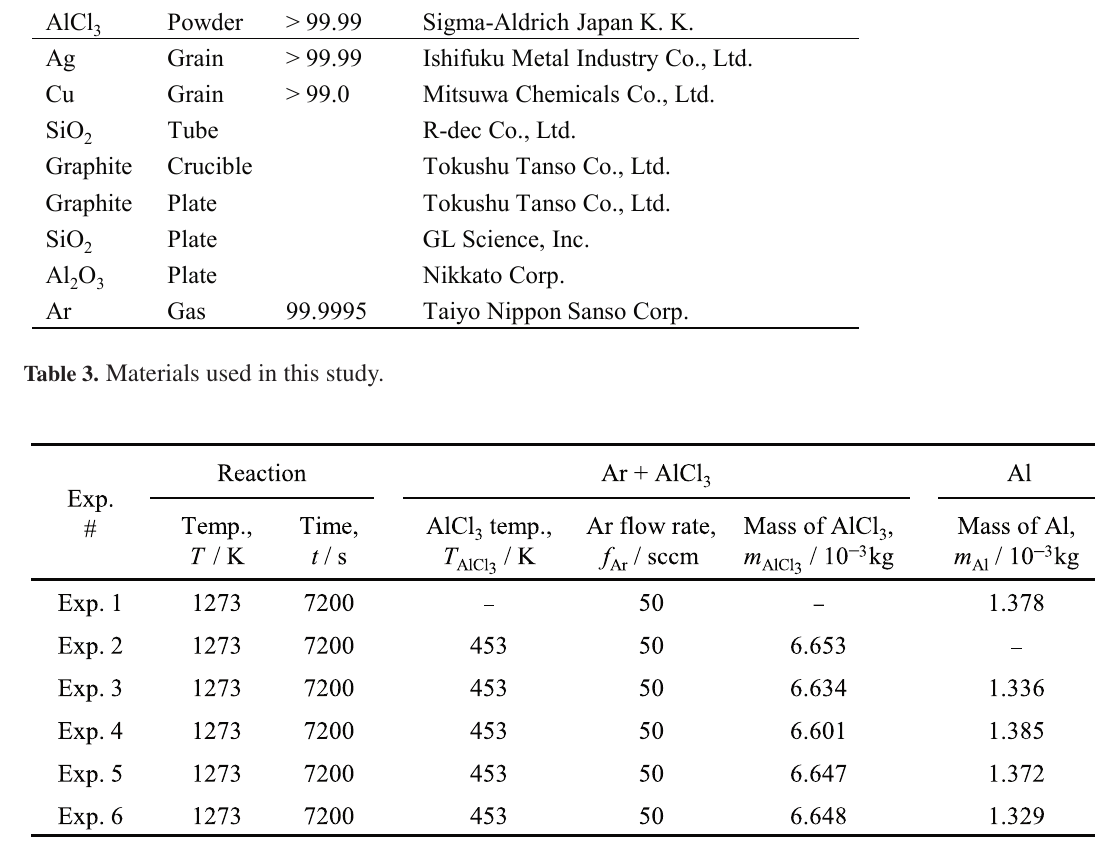
Table 4. Experimental conditions in this